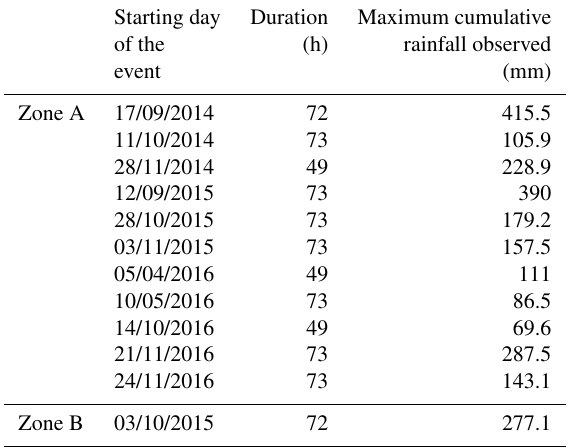
Table 2. Characteristics of the flash-flood events.